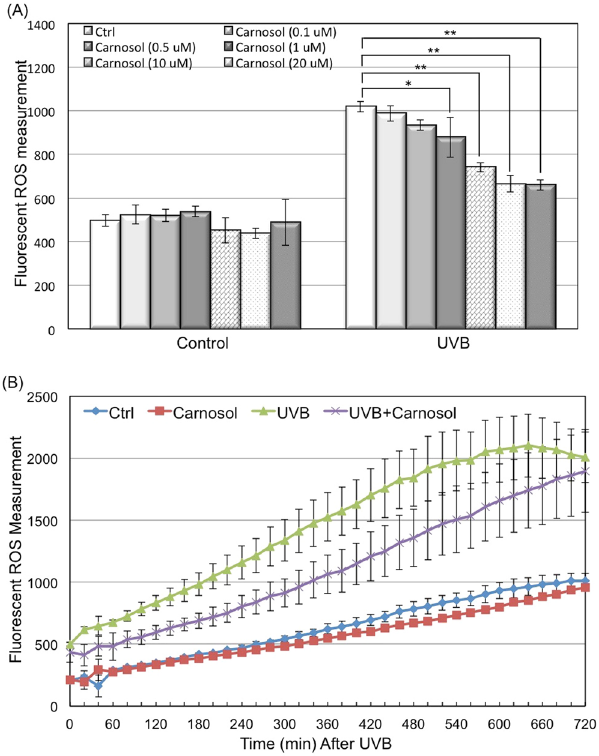
Figure 2. Dose and time dependent effect of carnosol on UVB-induced intracellular ROS level. HaCaT cells were seeded in 96 well plate and incubated with CM-H 2 DCFDA dye 60 minutes prior to UVB exposure, with or without carnosol treatment. ( A ) ROS was measured at 6 hours post UVB radiation with indicated concentration of carnosol treatment using ex490/em520 nm. ( B ) Carnosol (20 μ M) was added to cells 60 minutes prior to UVB exposure and ROS level was measured at 20 minutes intervals post UVB radiation until 12 hours. * p < 0.05, ** p <